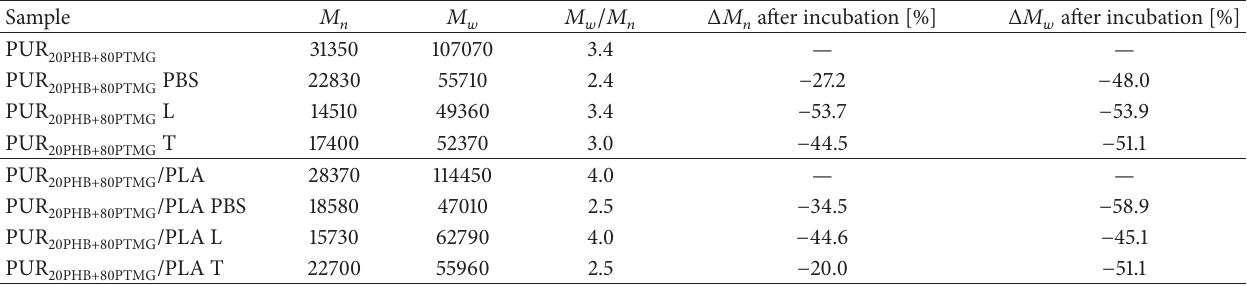
Table 5: Molecular weights of polyurethane (PUR weeks), lipase (L), and trypsin (T) (2 weeks).